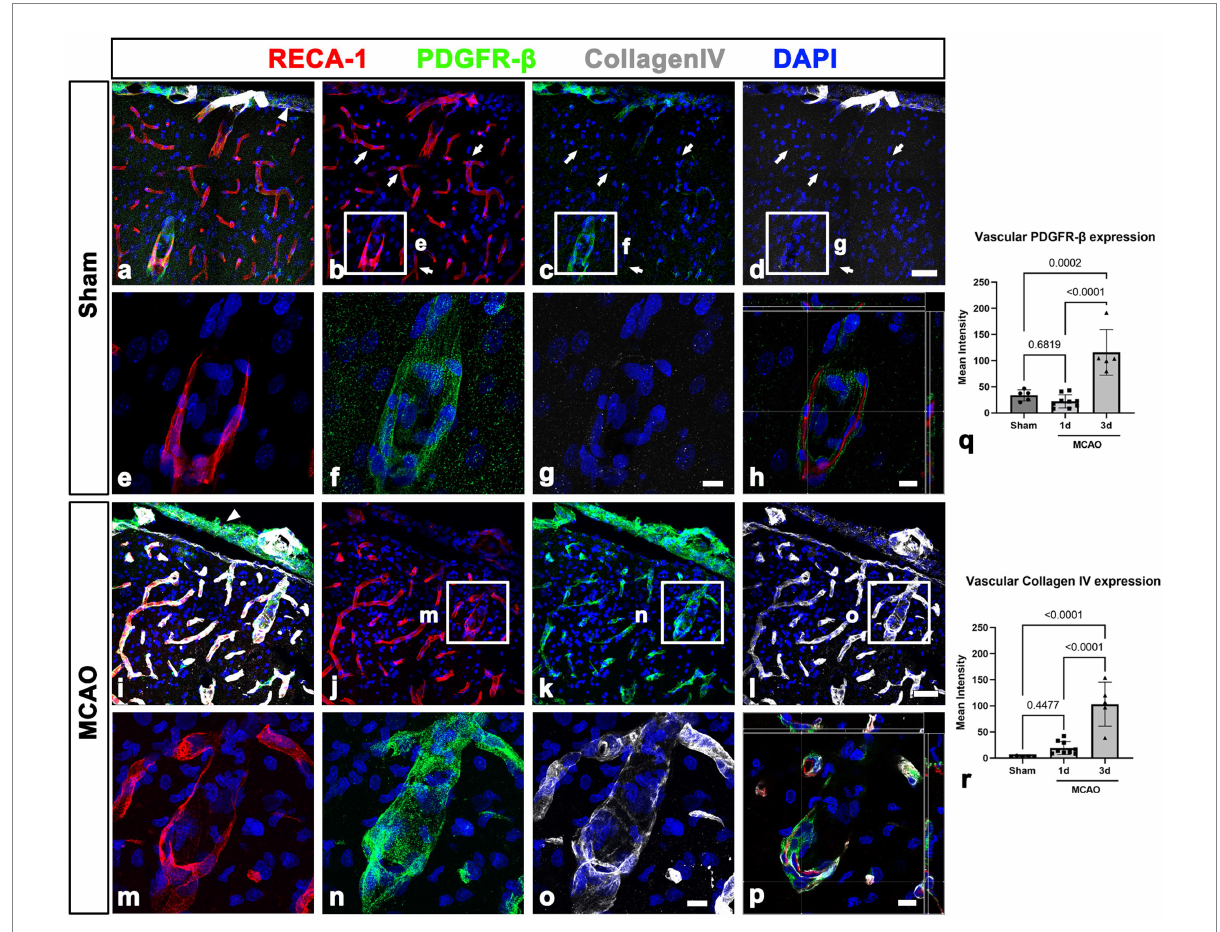
FIGURE 3 PDGFR- β expression profiles and their spatial relationship with collagen in the leptomeninges and underlying cortex in sham-operated and MCAO rats. (A–H) Triple labeling for PDGFR- β , RECA-1, and collagen IV. (A–D) In sham-operated rats, collagen IV is detected in PDGFR- β -positive leptomeninges (arrowhead in A ) including in their vessels but not in PDGFR- β -positive larger cortical vessels. Note the absence of immunoreactivities for PDGFR- β and collagen in the capillary-like vessels (arrows in B–D ). (E–G) Higher magnification views of the boxed areas in (B–D) , respectively. (H) The orthogonal view of boxed areas in (B–D) . (I–L) At 3 days after MCAO, PDGFR- β and collagen IV have overlapping distributions within both leptomeninges (arrowhead in E ) and most cortical blood vessels. (M–O) Higher magnification views of the boxed areas in (J–L) , respectively. (P) The orthogonal view of boxed areas in (J–L) . (Q,R) Quantitative analysis showing that the relative intensities of both PDGFR- β and collagen IV in cortical blood vessels at day 3 after reperfusion are significantly higher in MCAO rats than in sham-operated rats ( n = 5–7 sections from 6 to 8 rats per time points, one-way ANOVA with Tukey’s multiple comparison test). Data are expressed as the mean ± SEM, and numbers on each bar graph indicate p values. Scale bars = 50 μ m for (A–D,I–L) 10 μ m for (E–H,M–P)